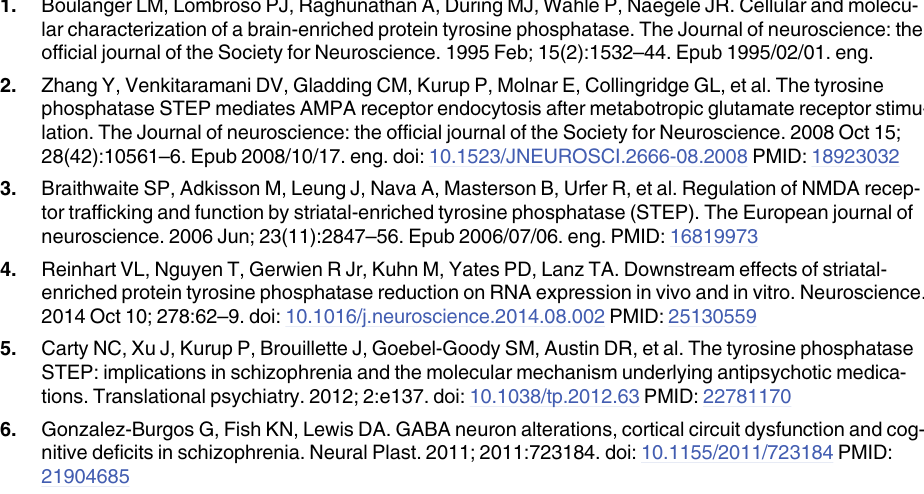
adjusted means. Table F . STEP46 protein in striatum: initial results for testing significance of fixed effects in the full mixed model, including all interactions between covariates and CASE factor. Table G . STEP46 protein in striatum: results of multiple comparisons tests for pairwise differences amongst covariate-adjusted